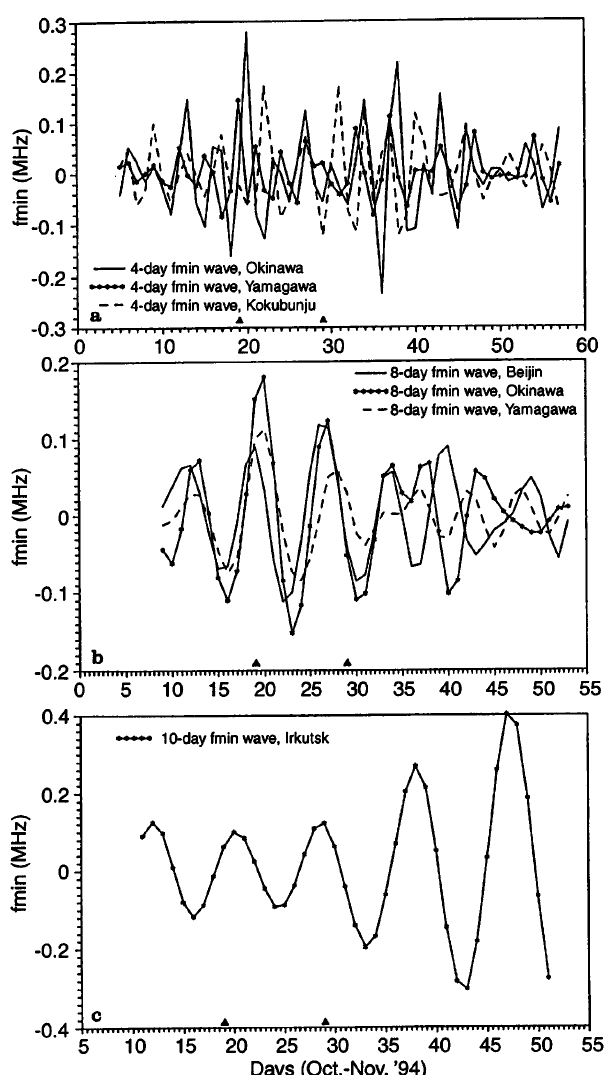
Fig. 5a–c. Filtered f data for Far East stations: a (cid:24) 4-day waves min observed in Okinawa ( solid line ), Yamagawa ( solid line with asterisks ) and Kokubunji ( dashed line ), b (cid:24) 8-day waves in Beijing ( solid line ), Okinawa ( solid line with asterisks ) and Yamagawa ( dashed line ), and c 10-day, wave, observed only in Irkutsk. SSCs are marked by solid triangles